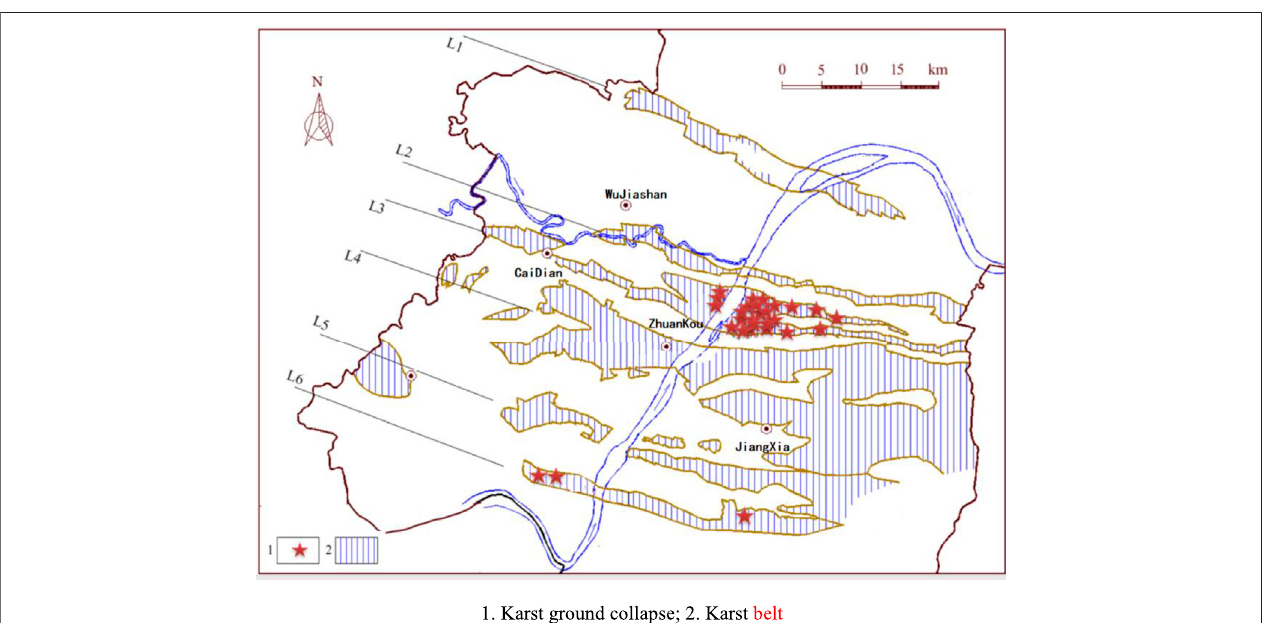
FIGURE 1 | Distribution diagram of karst belt and ground collapse in Wuhan City. 1. Karst ground collapse; 2. Karst belt.